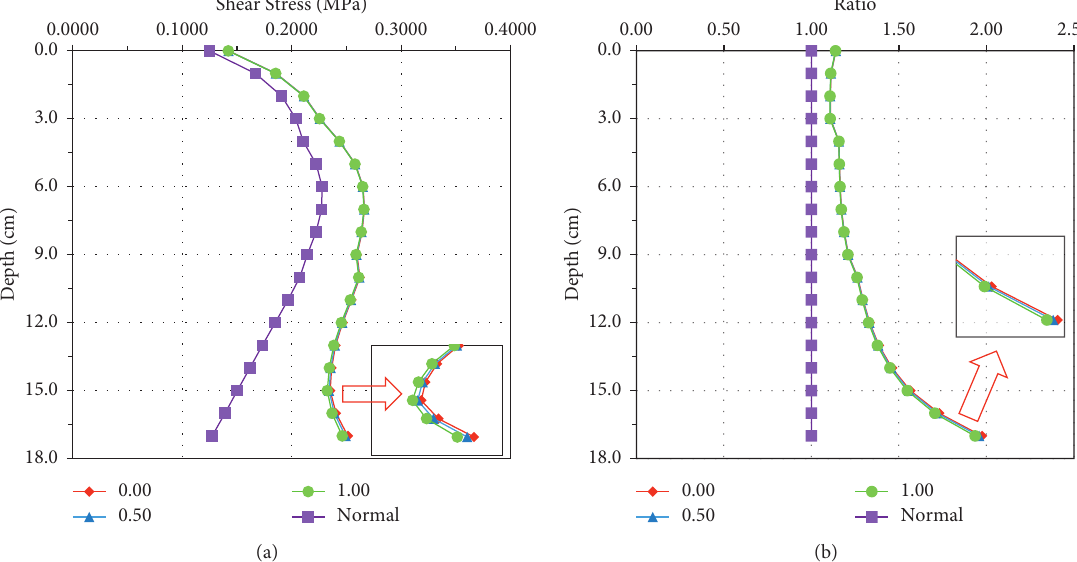
Figure 14: Effect of different interlayer bonding coefficients on the distribution of shear stress along with the depth: (a) normal value and (b) standardized value.